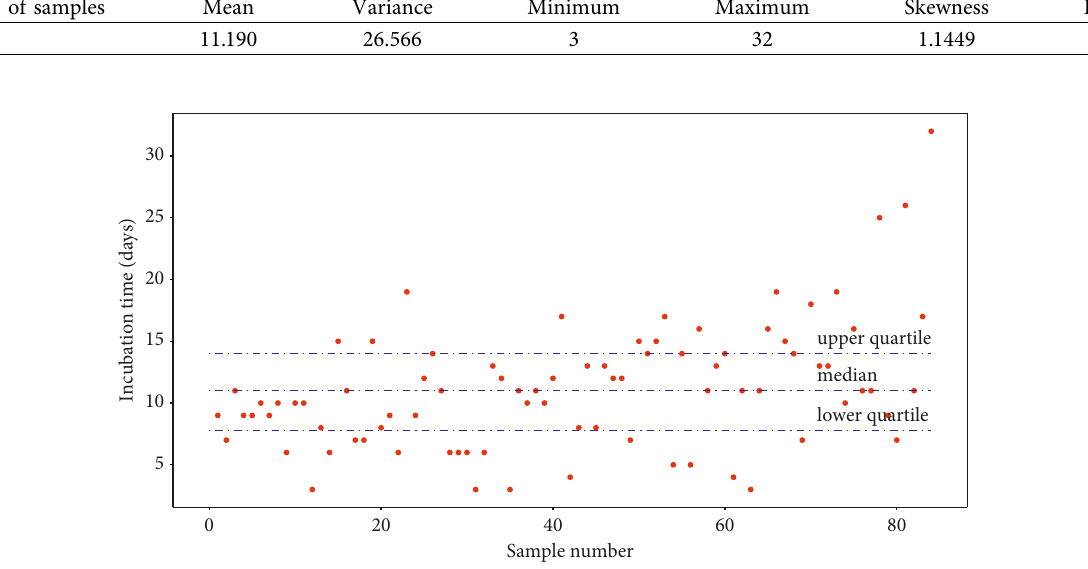
Figure 1: Scatter diagram of the